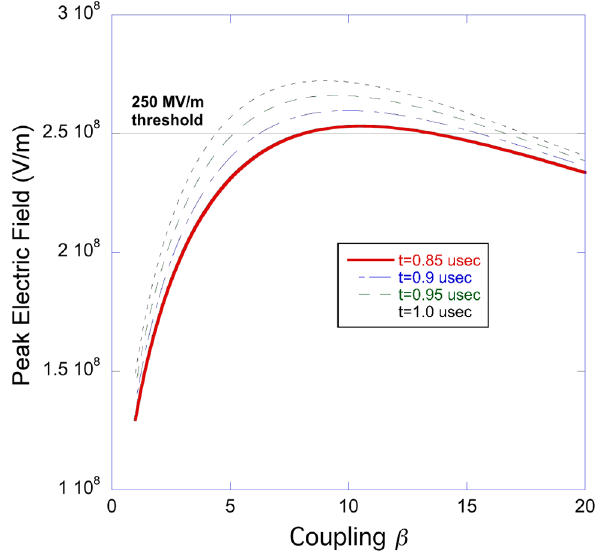
FIG. 15. Peak photocathode electric field as a function of β in 1.45 cell rf gun, for four different rf pulse